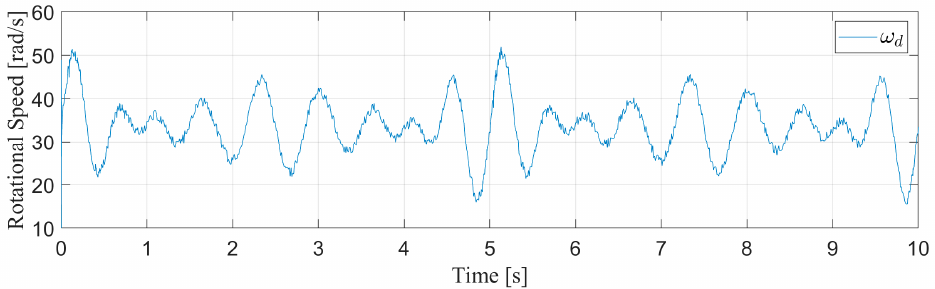
Figure 11. Desired speed trajectory based on turbulent wind speed profile.